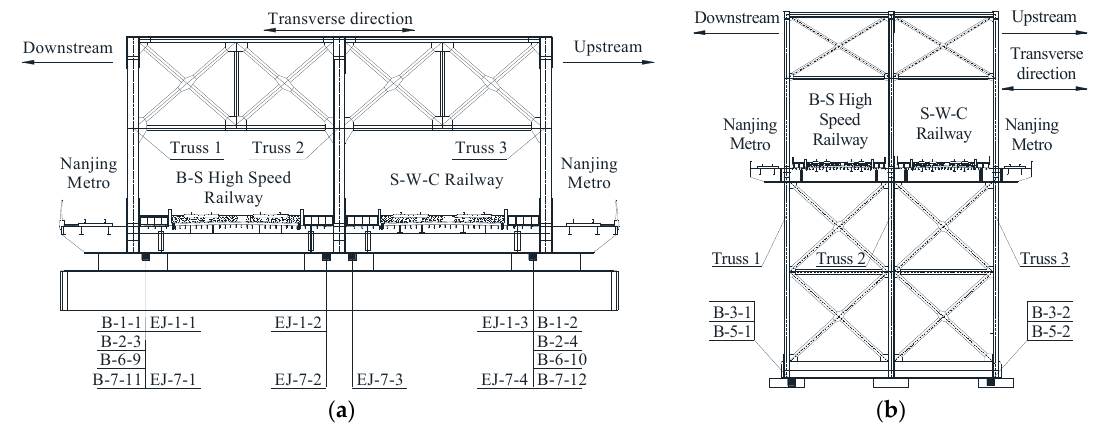
Figure 3. Locations of the magnetostrictive displacement sensors: ( a ) Pier 1 (2, 6, 7); ( b ) Pier 3 (5).